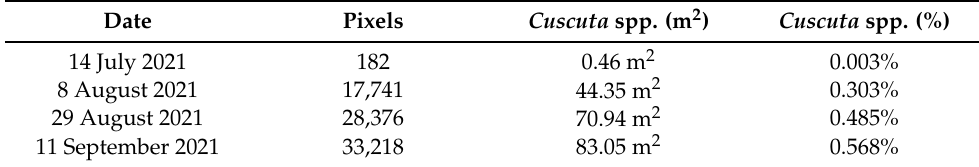
Table 4. Infested areas in the study